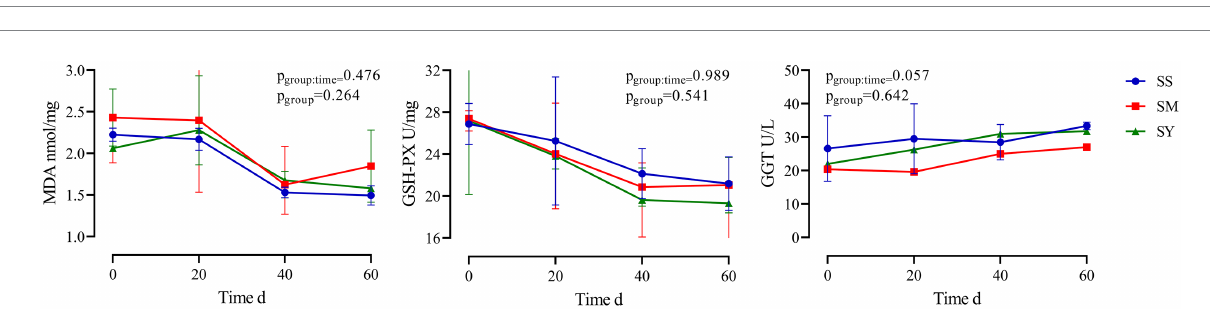
FIGURE 5 Effects of different Se sources on MDA concentrations and activities of GSH–Px and GGT in plasma of beef cattle ( n = 5) over the 60 d feeding period. (A) malondialdehyde (MDA) concentrations; (B) antioxidant enzyme glutathione peroxidase (GSH-PX) activity; (C) gamma-glutamyl transpeptidase (GGT) activity. * p < 0.05, ** p < 0.01. SS, diet supplemented 0.1 mg Se/kg DM from sodium selenite; SM, diet supplemented 0.1 mg Se/kg DM from selenomethionine; SY, diet supplemented 0.1 mg Se/kg DM from Se-enriched